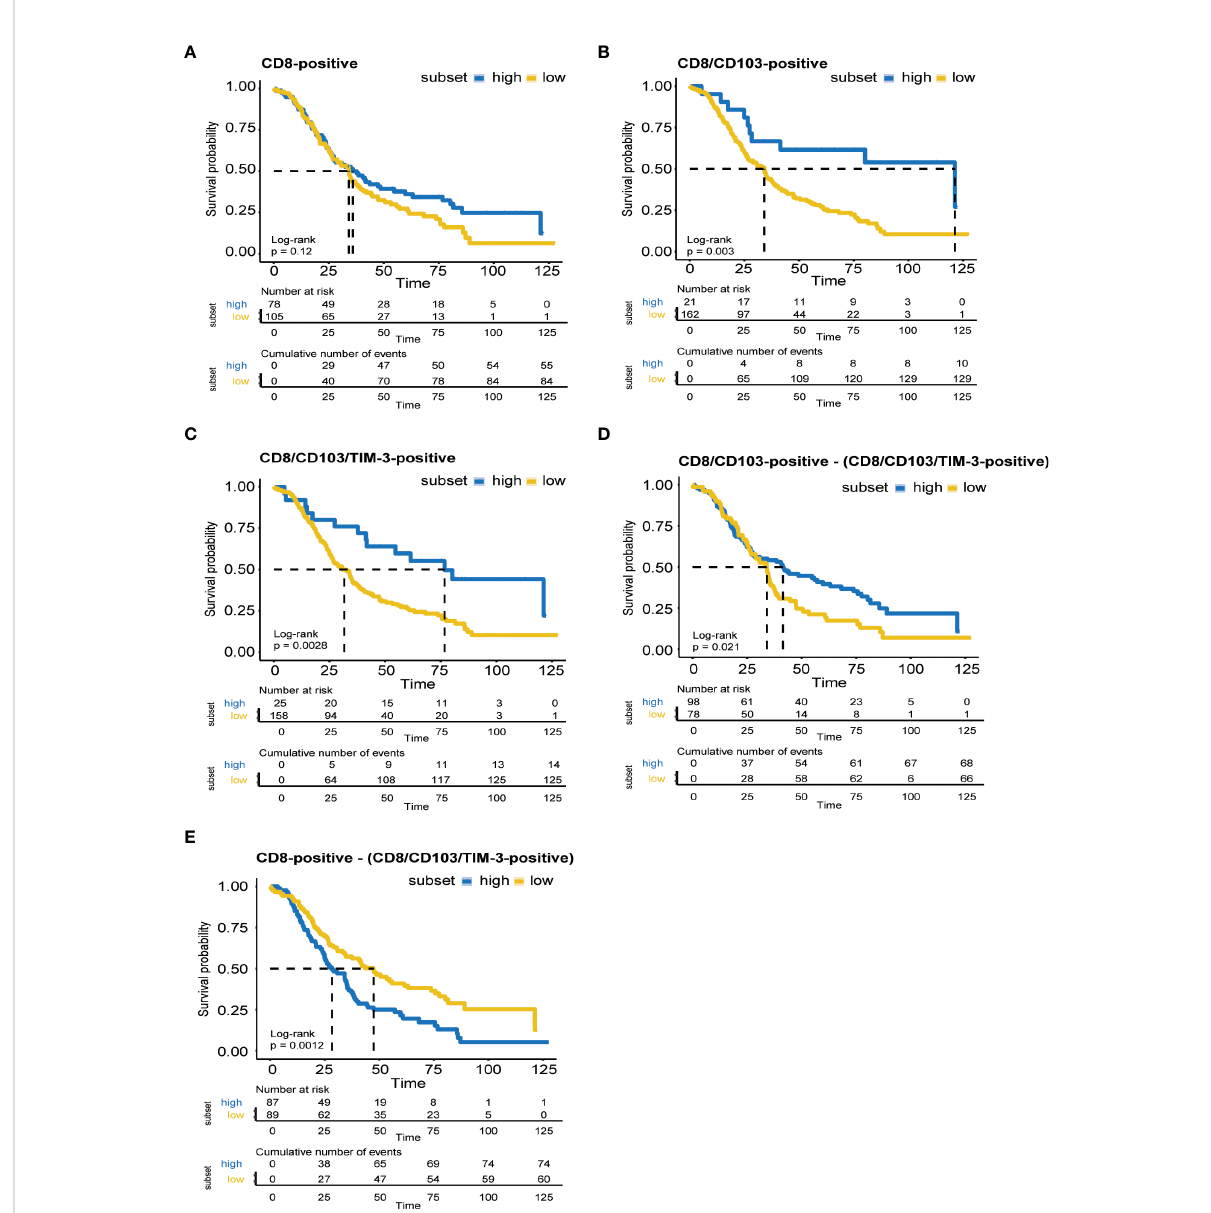
FIGURE 3 TIL TIM-3 expression associates with improved survival in EOC. Analyses of OS in months as a function of immune cell density based on immune cell populations CD8-positive (A) , CD8/CD103-positive (B) , CD8/CD103/TIM-3-positive (C) , CD8/CD103-positive - (CD8/CD103/TIM- 3-positive) (D) and CD8-positive - (CD8/CD103/TIM-3-positive) (E) performed by Cox proportional hazard models in R using packages RMS and survival, plotted using package ggPlot2. Proportionality of hazards was con fi rmed by scaled Schoenfeld residuals. Optimal cutoff analysis was determined in R using package Survminer. Survival curves were plotted in R using Survminer by using the Kaplan – Meier method. A p-value of <0.05 was used as cutoff for signi fi